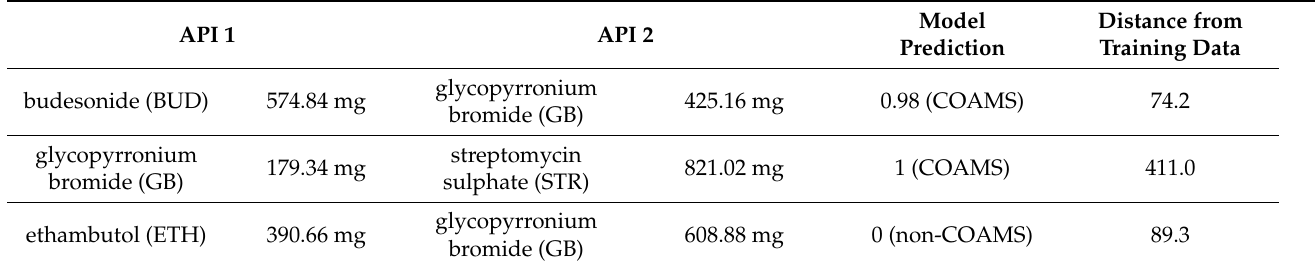
Table 3. API combinations for the milling experiments. The APIs were combined in a molar ratio of 1:1. The respective weights are given in the